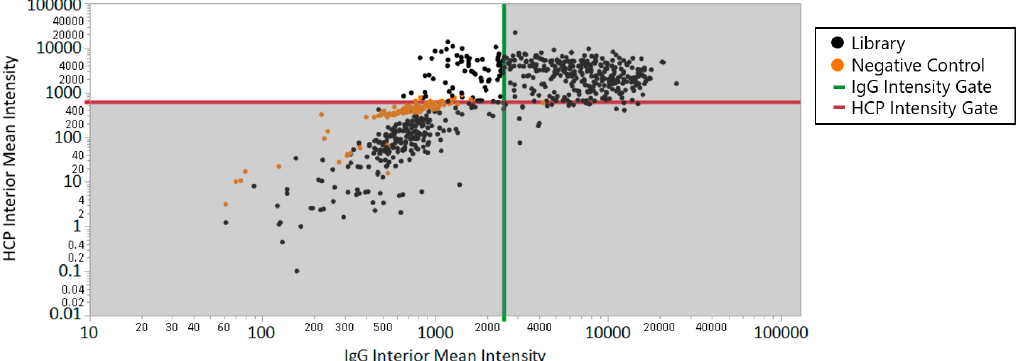
Figure 3. Immunoglobulin G (IgG) Interior Mean Intensity vs. Host Cell Protein (HCP) Interior Mean Intensity of limited library of X1-X2-X3-X4-X5-X6-G-S-G one bead one component (OBOC) peptide library incubated with Alexa Fluor 488-labeled polyclonal IgG and Alexa Fluor 546-labeled CHO-S clarified harvest host cell proteins. The pick gates at < 2500 FITC interior mean intensity for IgG and > 620 Rhodamine interior mean intensity for HCP are represented by the green and red reference lines, respectively. The highlighted region in the top left quadrant represents lead HCP-specific bead candidates.